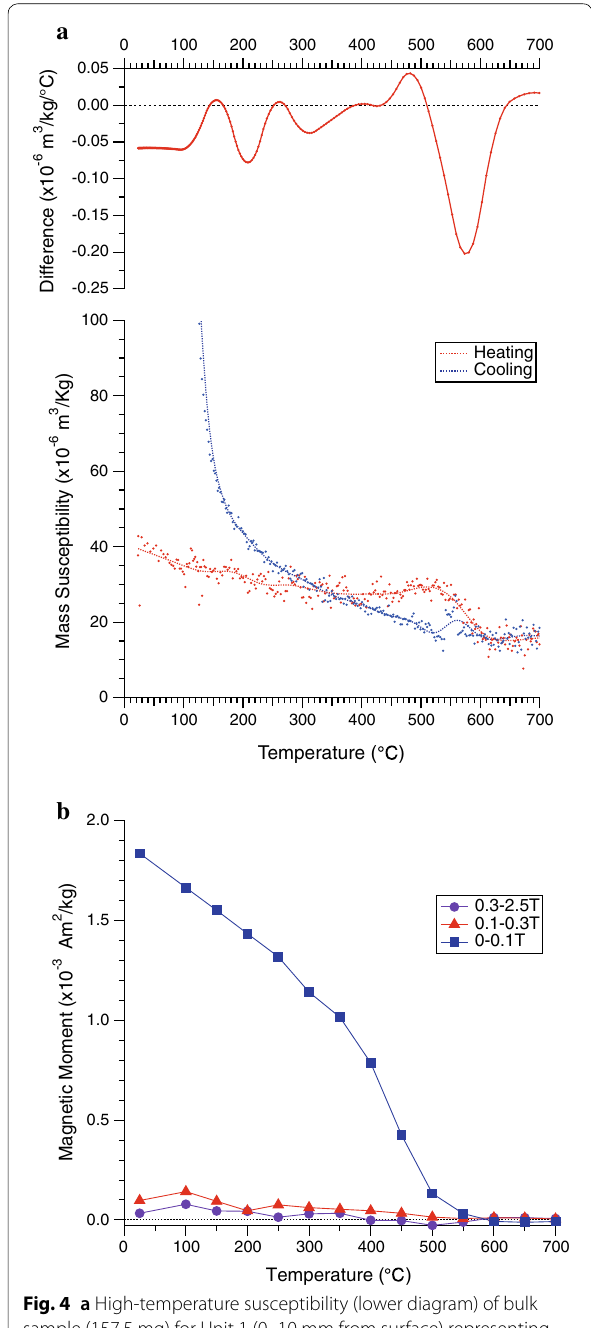
Fig. 4 a High-temperature susceptibility (lower diagram) of bulk sample (157.5 mg) for Unit 1 (0–10 mm from surface) representing heating (red dots) and cooling (blue dots) with spline smoothed curves (red and blue curves are for heating and cooling, respectively) with a derivative of the heating curve indicating a sharp drop at 573 °C (upper diagram). b Thermal demagnetization of orthogonal IRM based on Lowrie (1990) for a chip sample (20.4 mg) taken from Unit 1 (0–10 mm from surface). X (0.3–2.5 T), Y (0.1–0.3 T), and Z (0–0.1 T) axes are shown in purple, red, and blue,